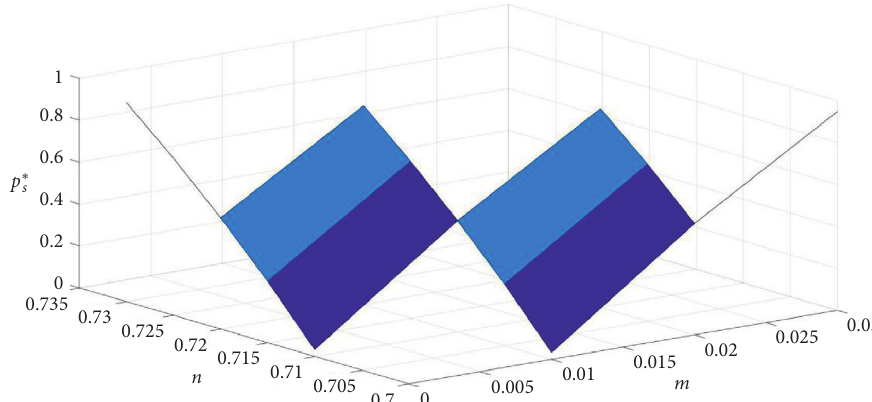
Figure 5: Simulation diagram of the influence of project success rate and the variation of project success rate p ∗ probability.